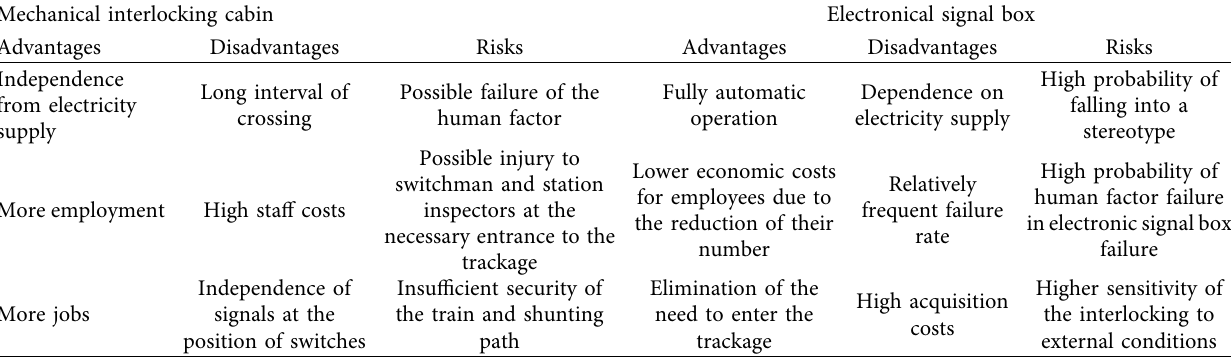
Table 11: Main advantages, disadvantages, and risks associated with the use of interlocking. Mechanical interlocking